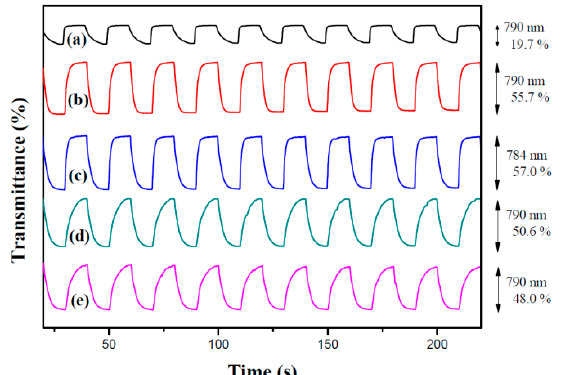
Figure 6. Optical contrast of ( a ) PdCz; ( b ) P(dCz2- co -dTC1); ( c ) P(dCz2- co -dTC2); ( d ) P(dCz1- co -dTC2) and ( e ) PdTC electrodes in an ACN / DCM (1:1, by volume) solution containing 0.2 M LiClO 4 with a residence time of 10 s.